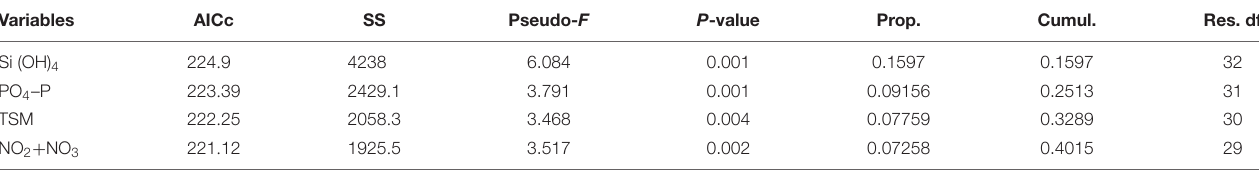
FIGURE 4 | Cluster analysis based on zooplankton abundance in the northern Bering Sea during July of 2017 and 2018 (A) . Five groups (A–E) were identified from the Bray–Curtis similarity connected with UPGMA. Mean abundance and species/taxon composition of each group (B) . dbRDA plots of the five groups with environmental parameters (C) . The direction and length of the lines indicate the relationship between groups and the strength of the relationship. The station IDs in the plots indicate the year-station number. NO, nitrate+nitrite; P, phosphate; Si, silicate; TSM, time since sea-ice melt. TABLE 1 | Summary table of the results of the DistLM sequential tests, results shown are for the model with the lowest AICc values for each response